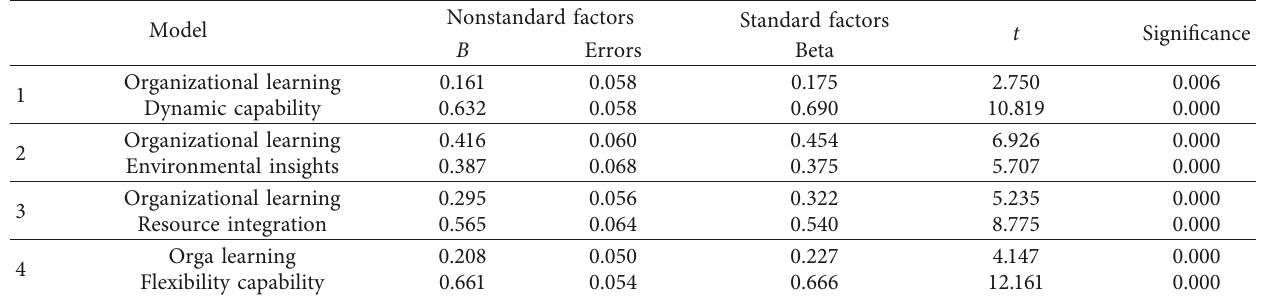
Table 8: Dynamic capacity mediation.